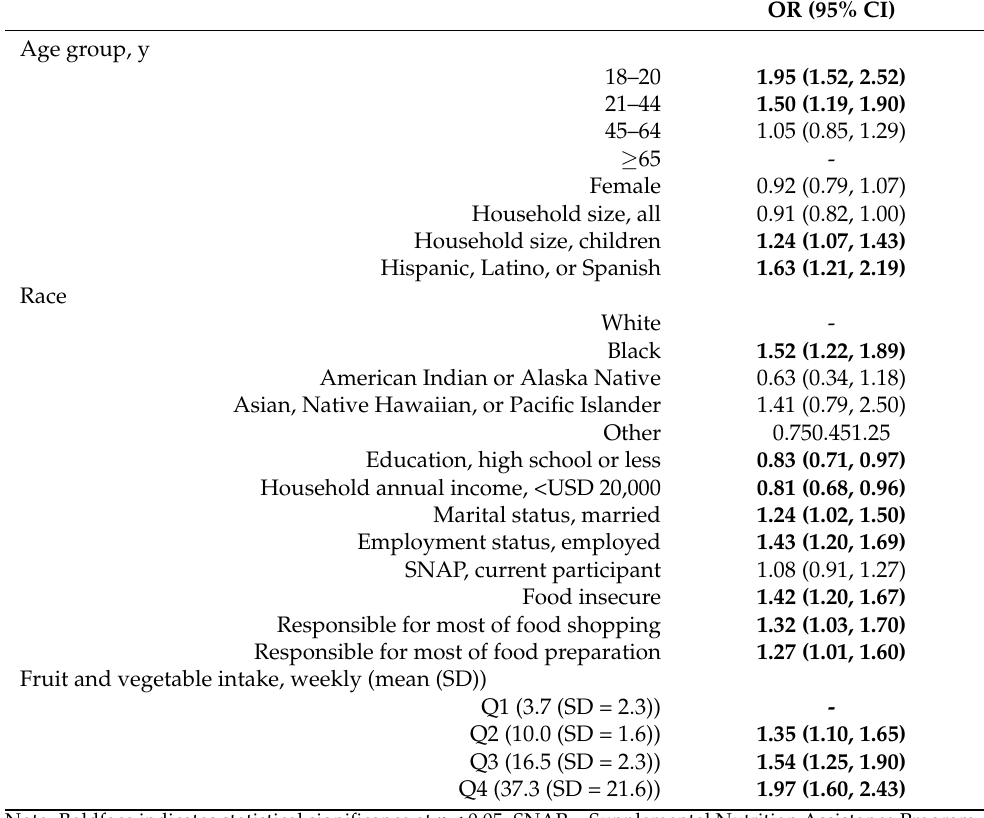
Table 3. Model-based associations between sociodemographic characteristics and self-reported online grocery shopping (yes/no).